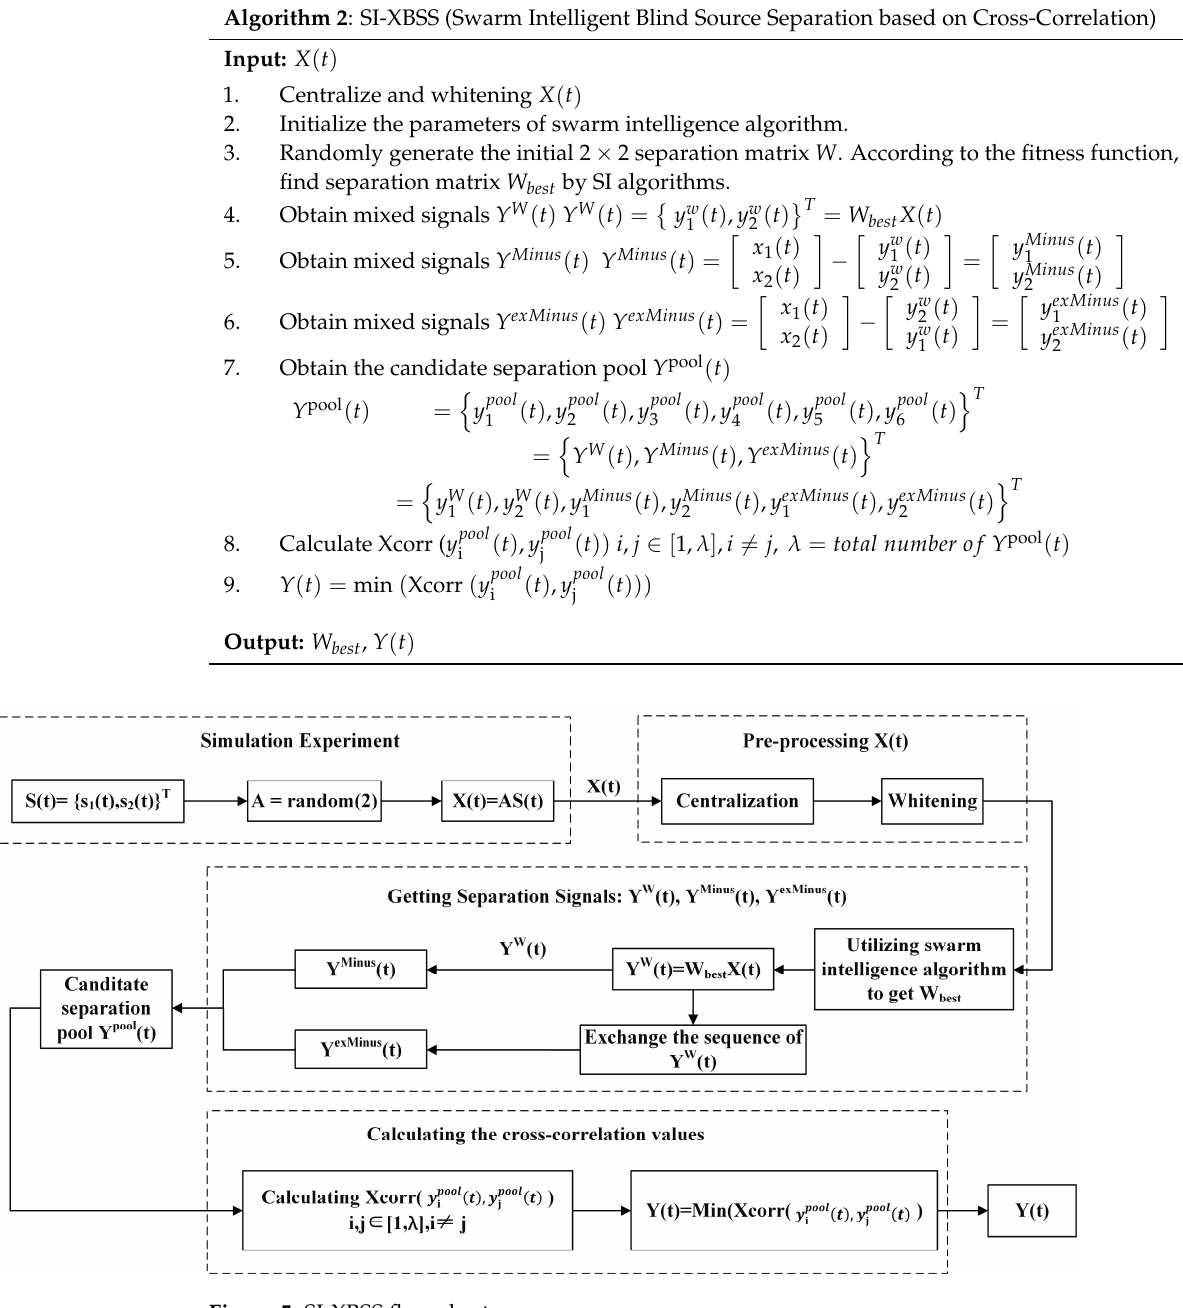
Algorithm 2 : SI-XBSS (Swarm Intelligent Blind Source Separation based on Cross-Corre- lation)